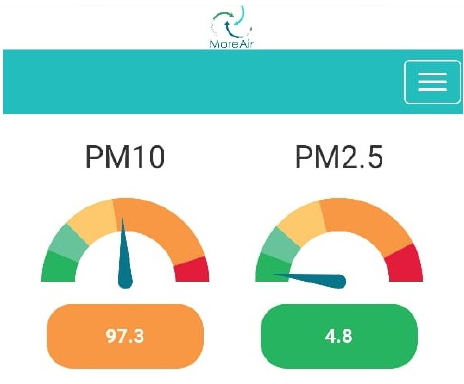
Figure 8. Chart representing the concentrations of PM 10 and PM 2.5 in µ g/m 3 as shown by the mobile app.